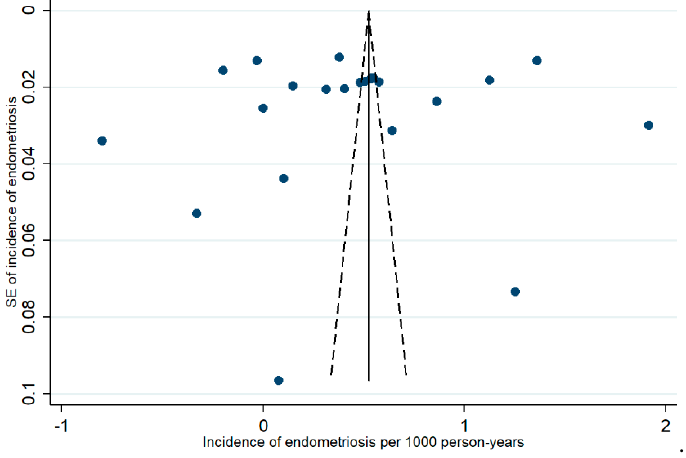
Figure A1. Funnel plot for prevalence data. Note: blue dots represent individual studies; the outer dotted line indicates the triangular region within which 95% of studies are expected to lie in the absence of both biases and heterogeneity; the solid vertical line represents the line of no effect, de- rived using fixed-effect meta-analysis.